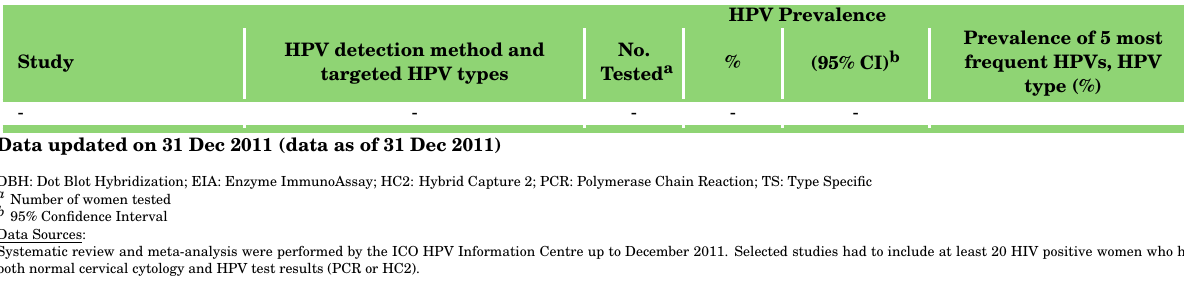
Table 24: Studies on HPV prevalence among HIV+ women with normal cytology in India